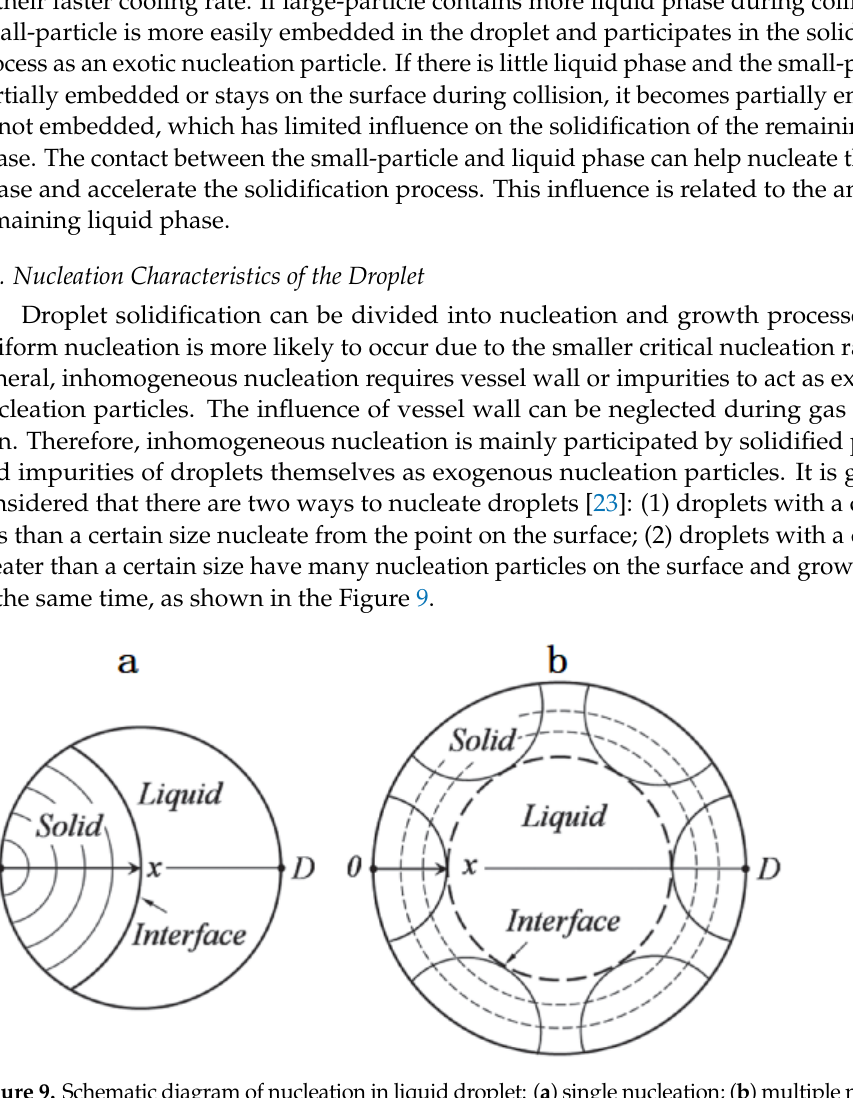
Figure 9. Schematic diagram of nucleation in liquid droplet: ( a ) single nucleation; ( b ) multiple nu-